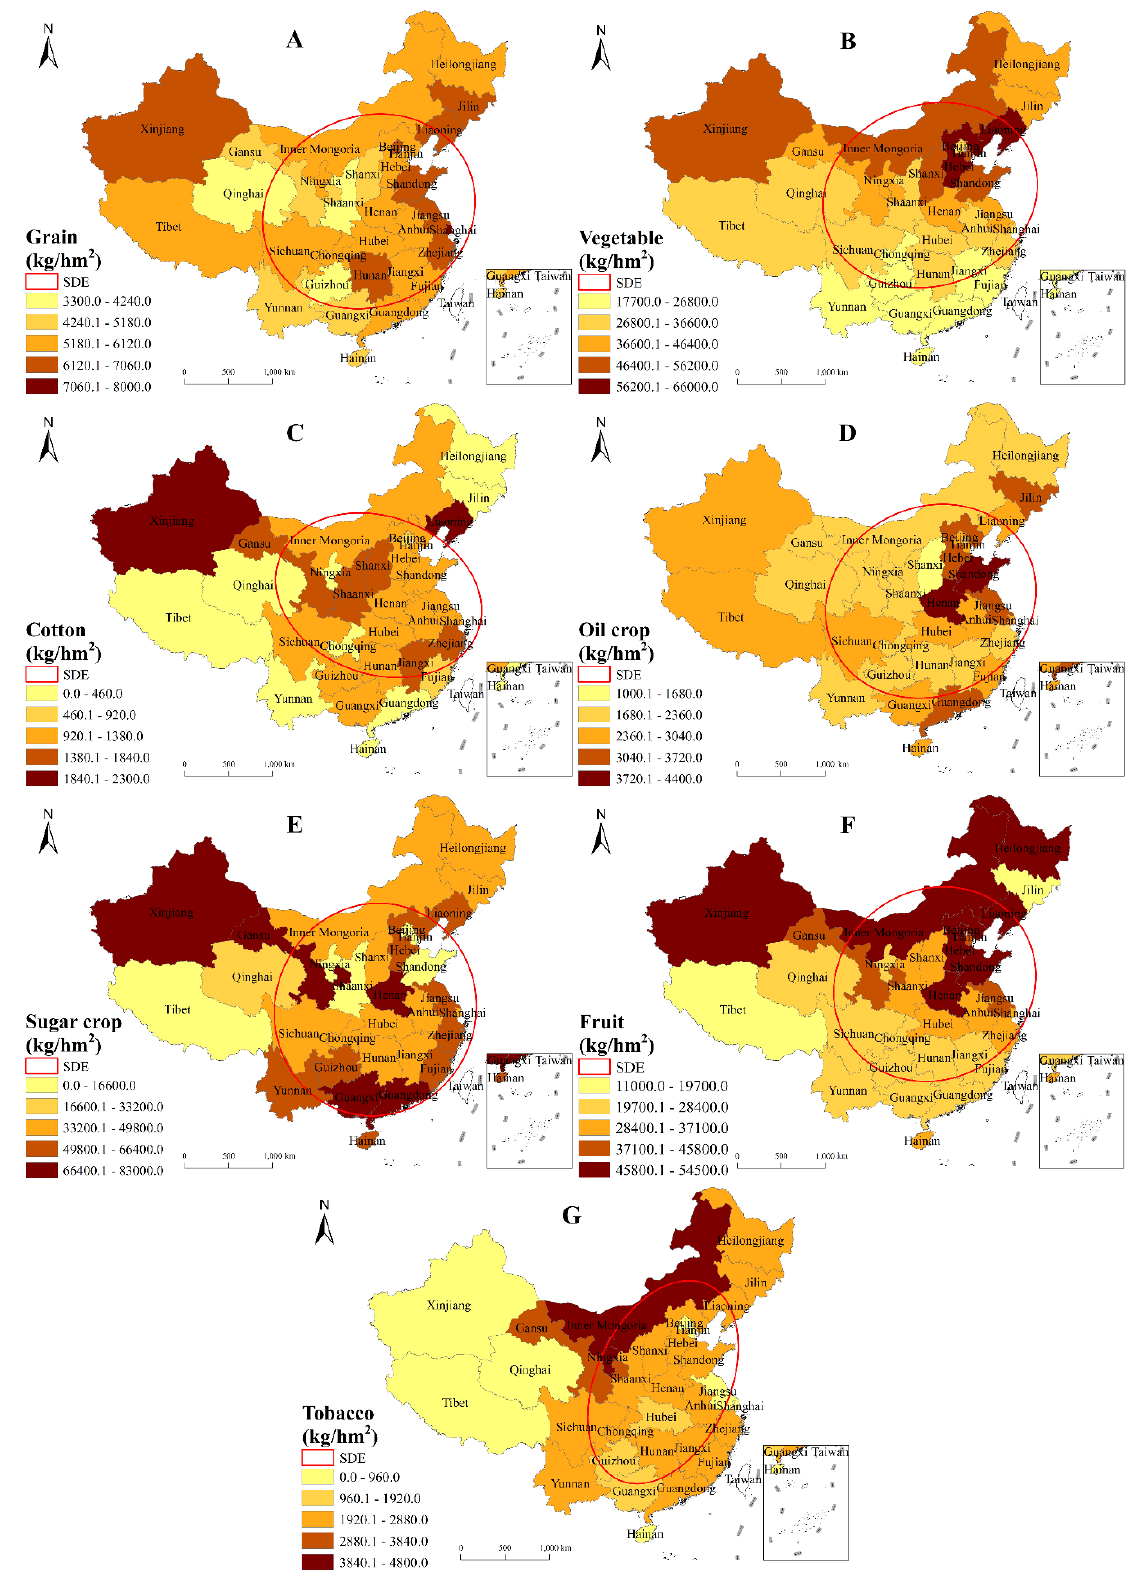
Figure 9. Output on per unit area of arable land in 2018.